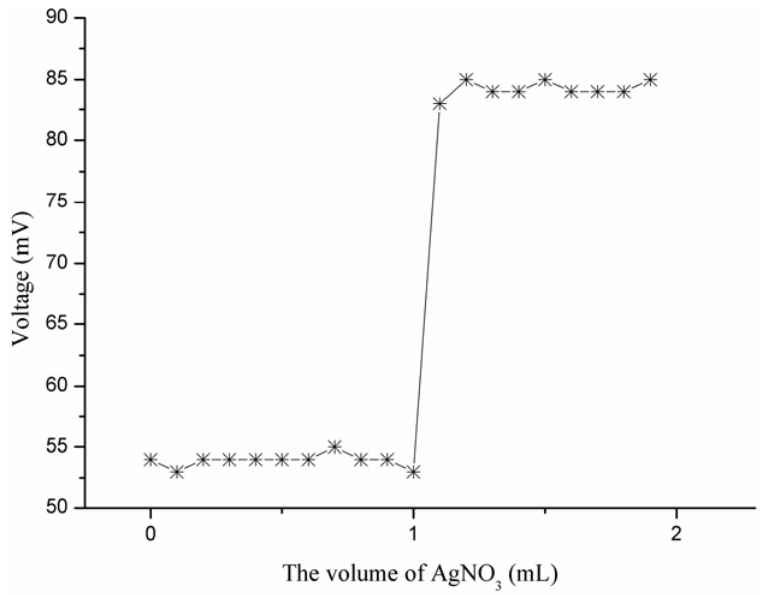
Figure 8. The potentiometric titration curve of iodide ion sensor in the 1 × 10 − 4 M solution of